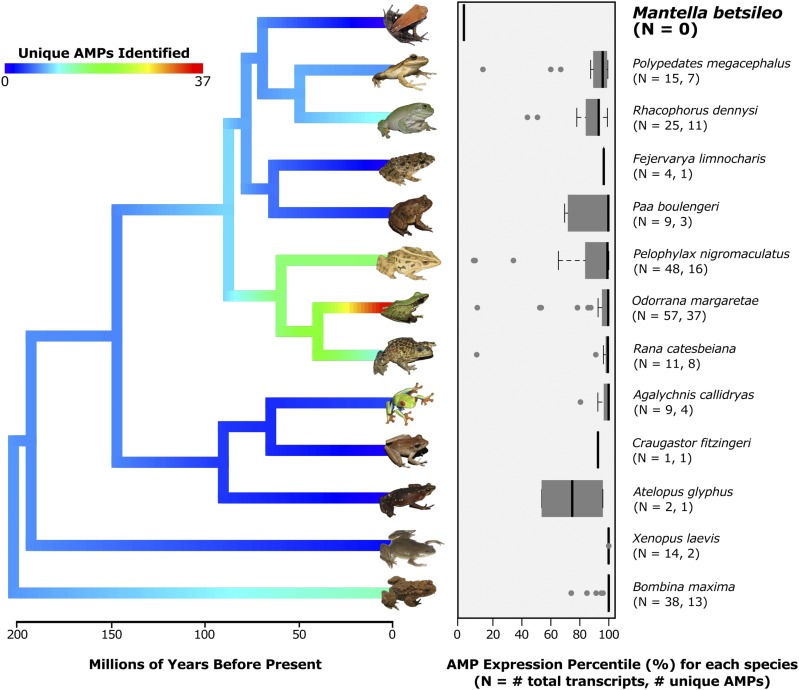
Antimicrobial peptides (AMPs) and expression levels among 13 frog skin transcriptomes. AMPs were not observed in the transcriptome of M. betsileo, but were highly expressed in all other frog clades. A phylogeny for thirteen frog species is shown on the left (reconstructed using TimeTree, Hedges et al. 2015; Kumar et al. 2017) and branches are colored according to the number of unique AMPs found in each taxon using phytools in R (Revell 2012). The AMP expression percentile (rank order of an AMP transcript divided by the total number of transcripts) is summarized for each taxon on the right. Sample sizes for the total number of AMP transcripts are positively correlated with the number of unique AMPs identified.